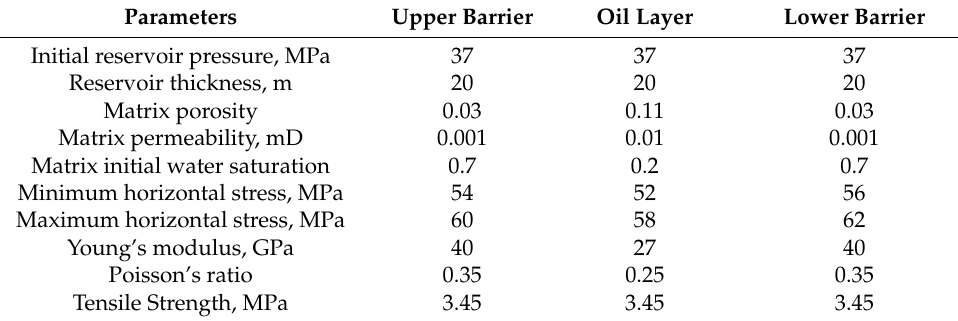
Table 1. Basic reservoir input parameters.